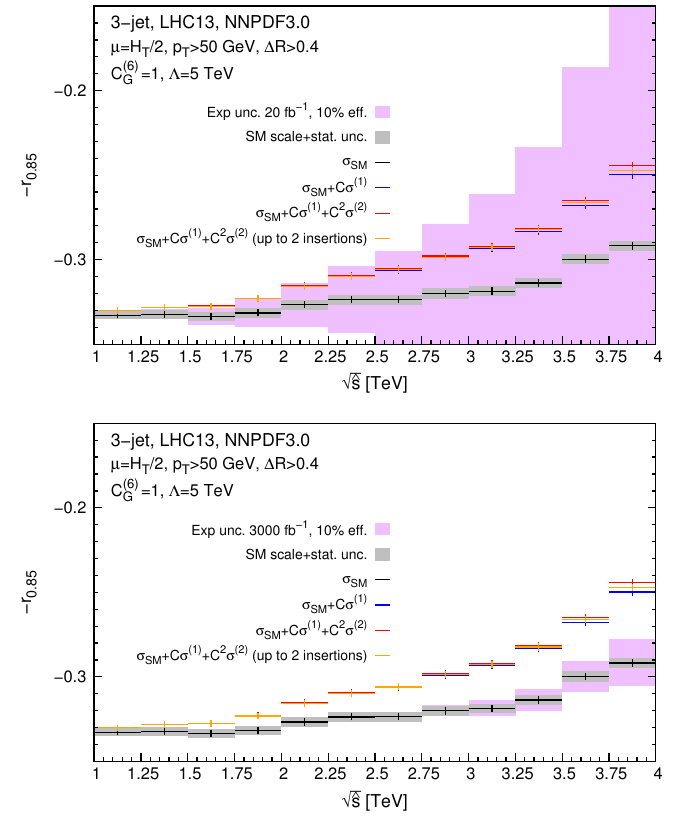
Figure 17 . Distribution of r 0 : 85 as de(cid:12)ned in Equation as a function of the centre-of-mass energy in three-jet production with the cuts de(cid:12)ned in eqs. (3.2) and (3.3), along with the expected experimental uncertainties for di(cid:11)erent integrated luminosities at the LHC.